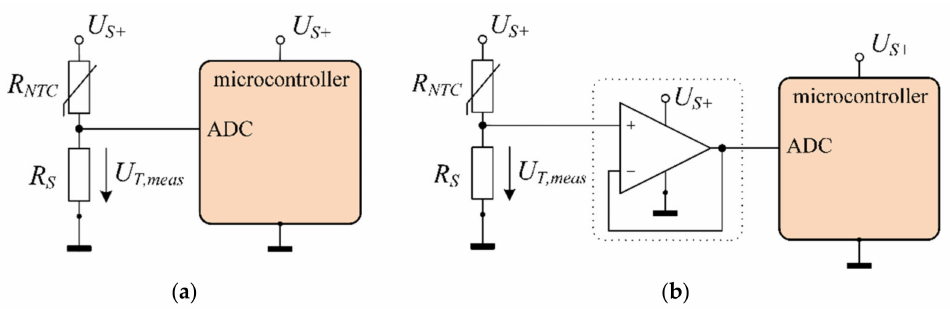
Figure 3. Conditioning circuit: ( a ) Proposed; ( b ) Optional.